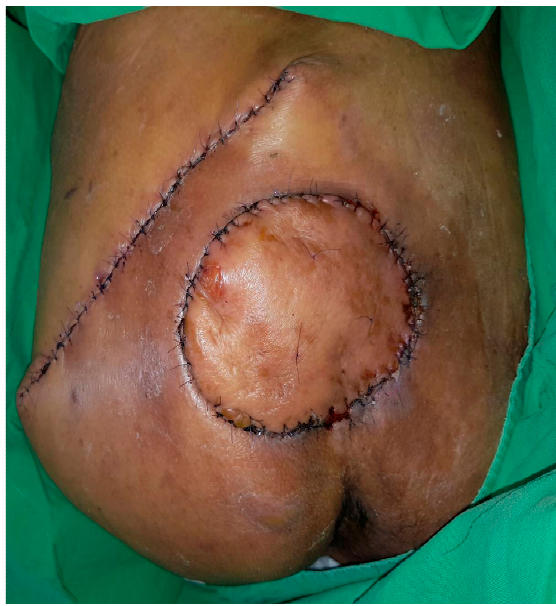
Figure 6. Post-operation day 10, the surgical wound is in the process of healing well.